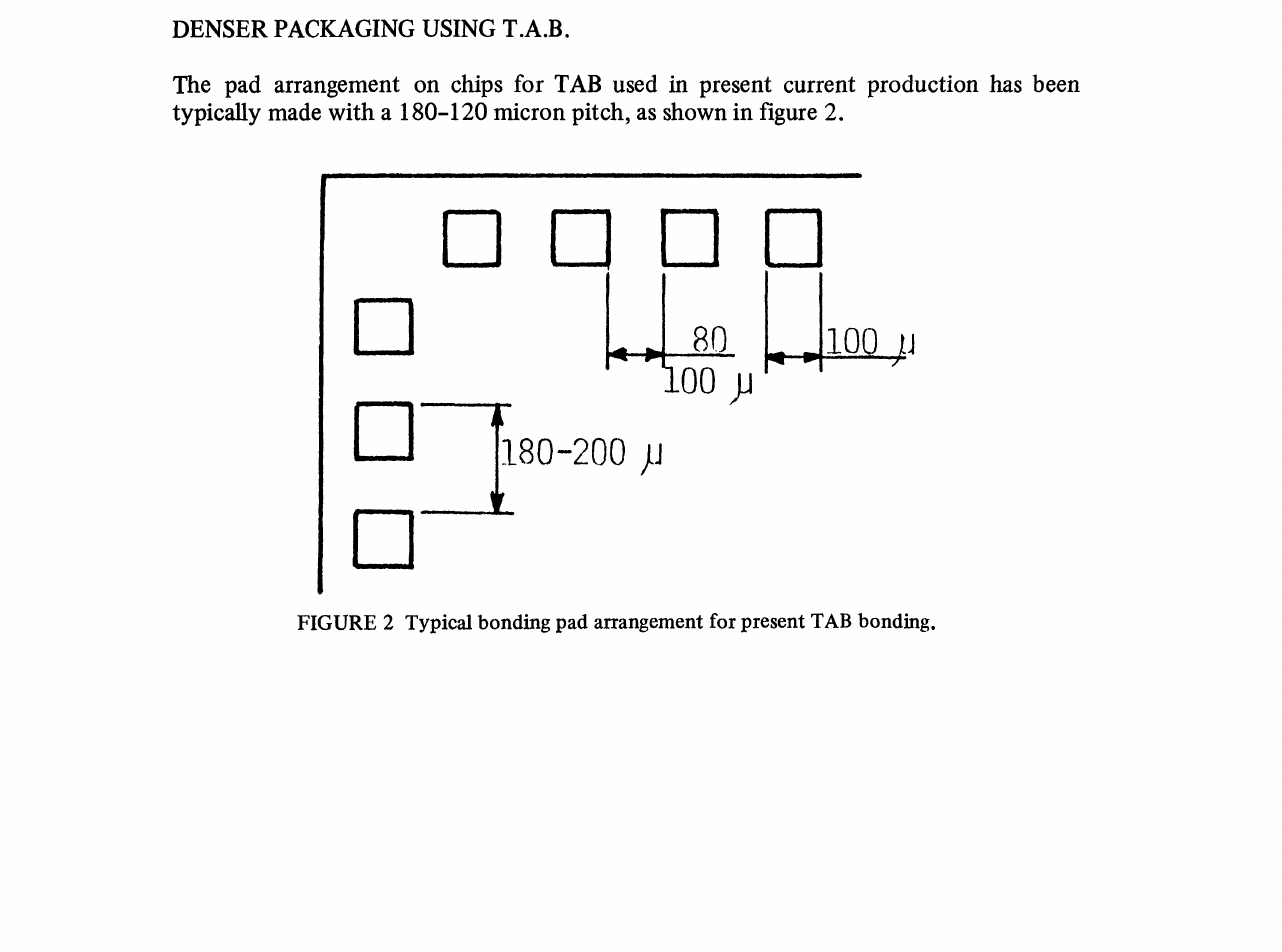
FIGURE 2 Typical bonding pad arrangement for present TAB